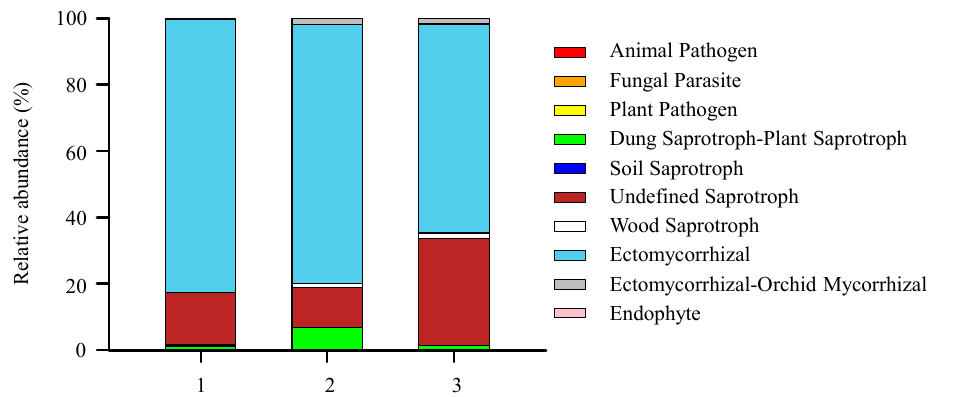
Figure 4. Compositions of fungal functional groups (guild) inferred by FUNGuild in tree clusters varying in tree species richness, with one, two, and three tree species combinations.